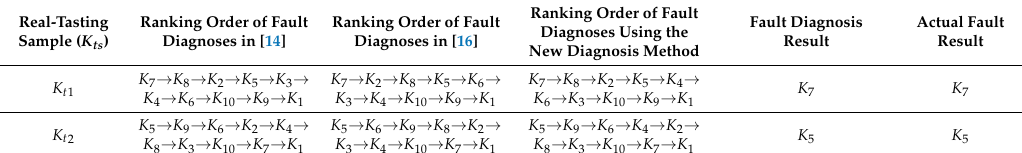
Table 9. Various fault diagnosis results and actual fault results of the steam